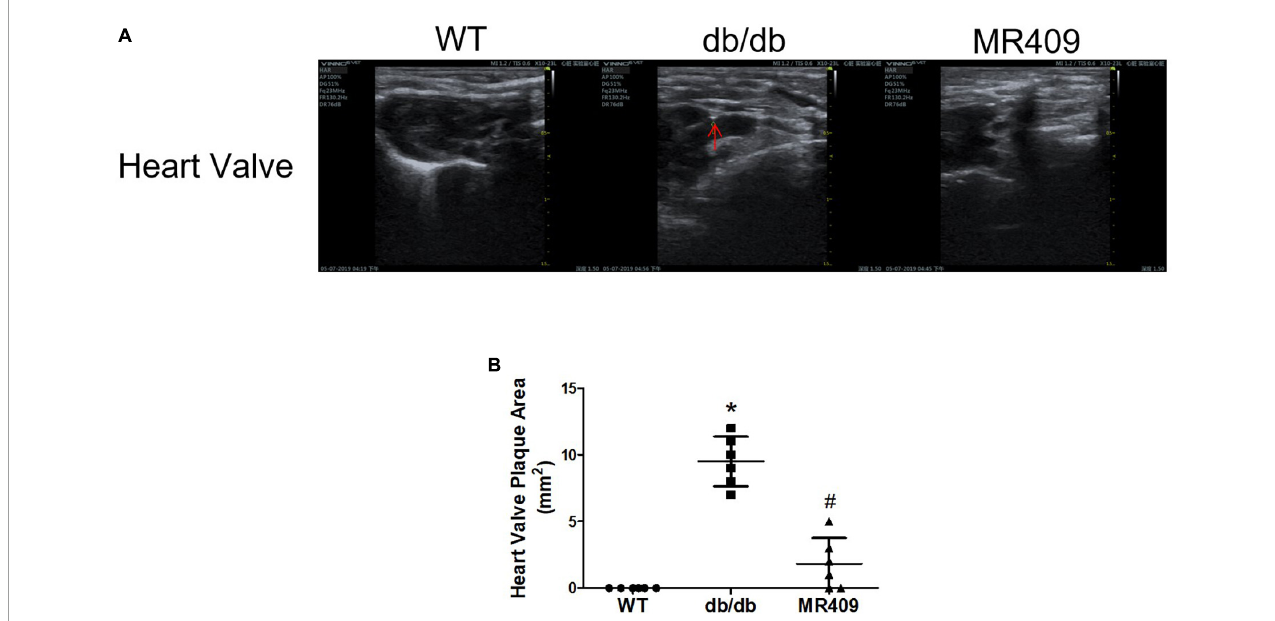
FIGURE4 Treatment with MR409 attenuates heart valve calcification (A) in diabetic db/db mice. Heart valve calcification was detected with high-resolution Doppler image system for small animal. Representative images of heart valve (A) calcification, the quantitation of heart valve (B) calcification. N = 6,